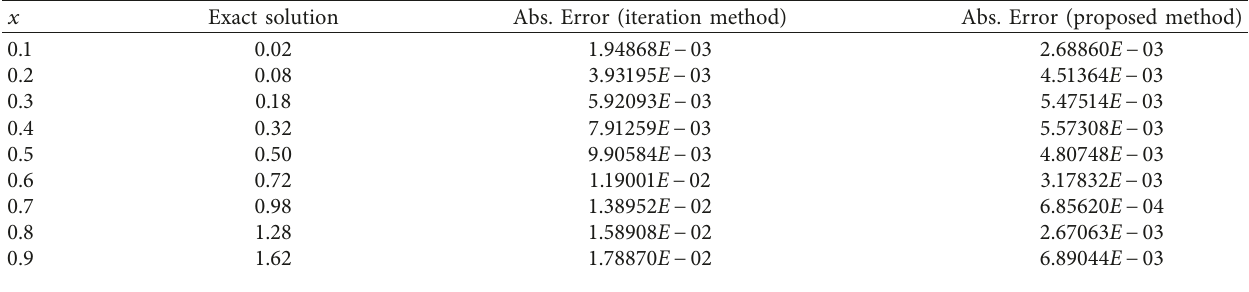
Table 2: Comparison of the absolute errors obtained by proposed method with the iteration method used in [17] for Example 2. x Exact solution Abs. Error (iteration